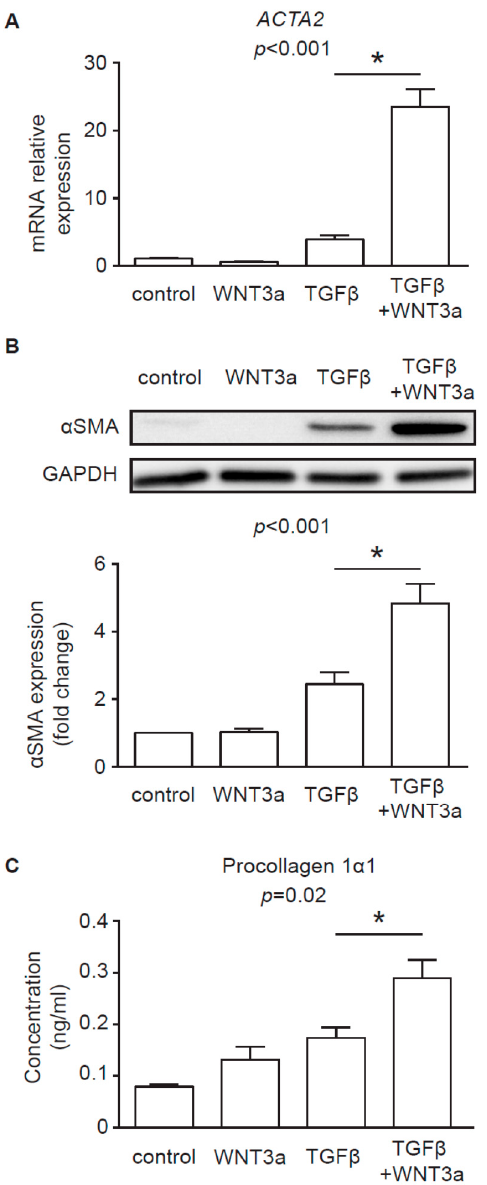
Figure 4. WNT3a promotes myofibroblast differentiation in the presence of TGF- β . Human cardiac fibroblasts were stimulated with conditioned medium produced by L-WNT3a or control L cells in the presence or absence of 10 ng/mL TGF- β . Panel ( A ) indicates expression of ACTA2 (gene encoding α SMA, n = 5) and panel ( B ) illustrates representative immunoblot and the respective quantifications of α SMA ( n = 5) 72 h after stimulation. Panel ( C ) shows collagen I alpha 1 levels measured in supernatants of cardiac fibroblasts treated for 5 days as indicated ( n = 4). Graphs show means ± SEM, p values computed using two-way ANOVA followed by Tukey’s multiple comparisons test, * p < 0.05 (post-hoc TGF- β vs TGF- β +WNT3a).